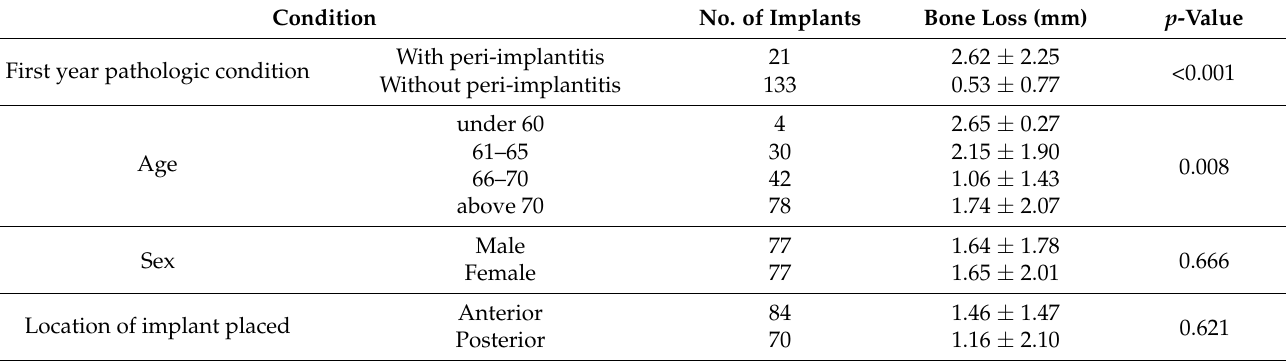
Table 7. p -value and MBL by